Question: What style of plot is this figure drawn as?
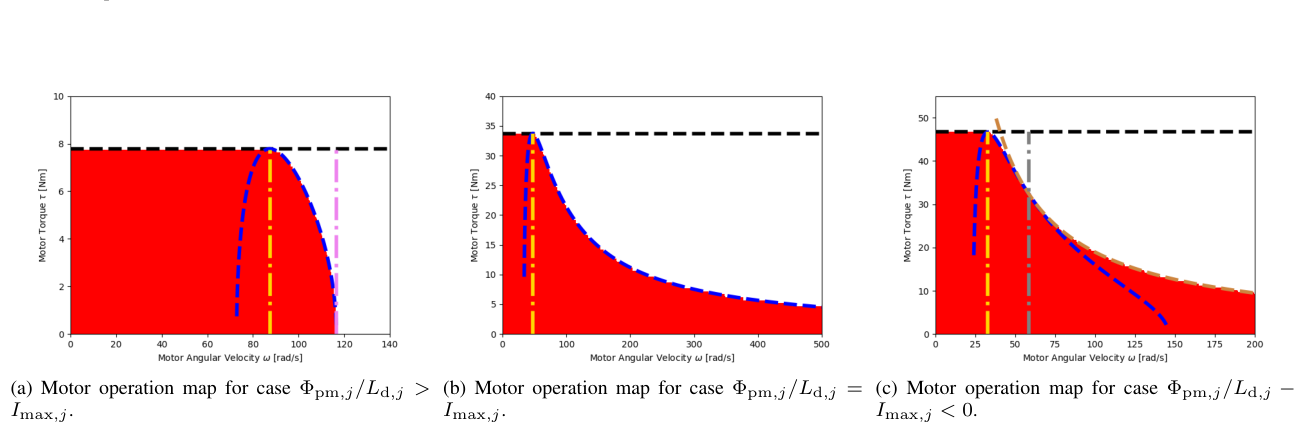
Answer: line